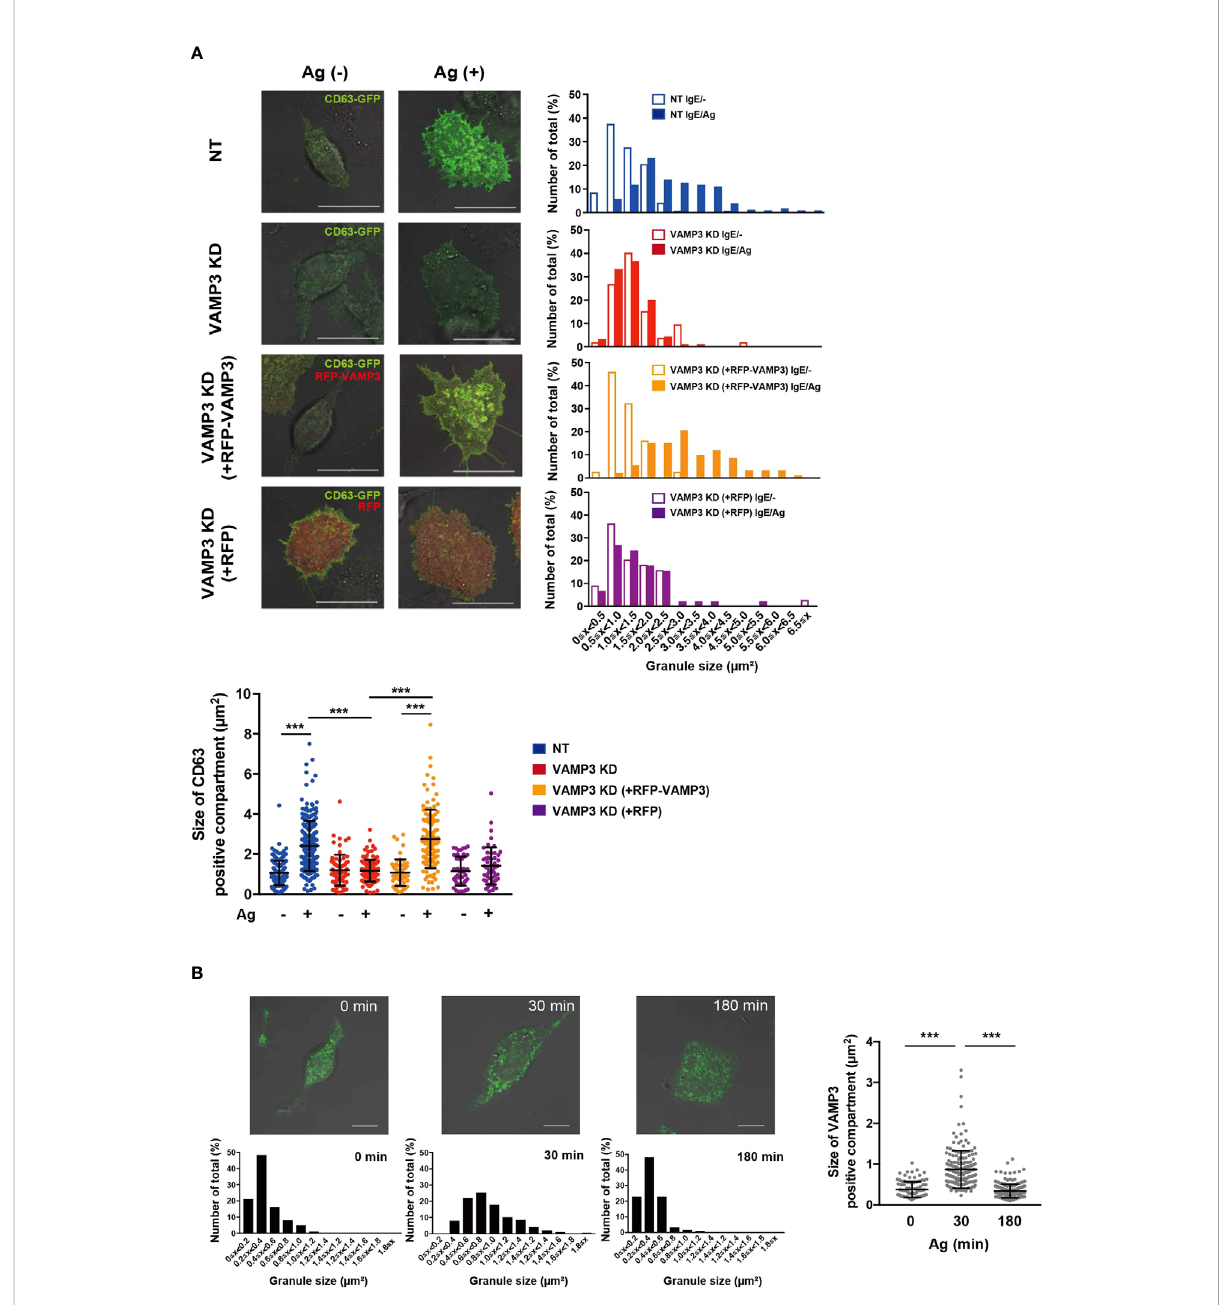
FIGURE 2 VAMP3 mediates granule-to-granule fusions during granule exocytosis VAMP3-mediated granule-to-granule fusion was analyzed using confocal laser scanning microscopy. (A) Cultured cells were transfected with GFP-tagged CD63 and/or RFP-tagged VAMP3 and stimulated with Ag (50 ng/ml) for 30 min. Bar graphs show size distribution of the CD63 positive granule; representative images are shown from three independent experiments (magni fi cation ×63, scale bar = 20 m m). Dot plot represents the average size of granules in all analyzed events (granules) counted from 47 – 236 granules from 3 – 5 cells/sample from 3 independent experiments. (B) IgE/Ag stimulated RBL-2H3 cells were stained for VAMP3. Green indicates Alexa 488-stained VAMP3. Bar graphs represent size distribution of the VAMP3 positive granule analyzed; representative images are shown from three independent experiments (magni fi cation ×63, scale bar = 10 m m). Dot plot represents the average size of granules in all analyzed events (granules) counted from 101 – 235 granules from 3 – 5 cells/sample from three independent experiments. NT: control knockdown with a non-targeting shRNA plasmid. Ag: antigen.